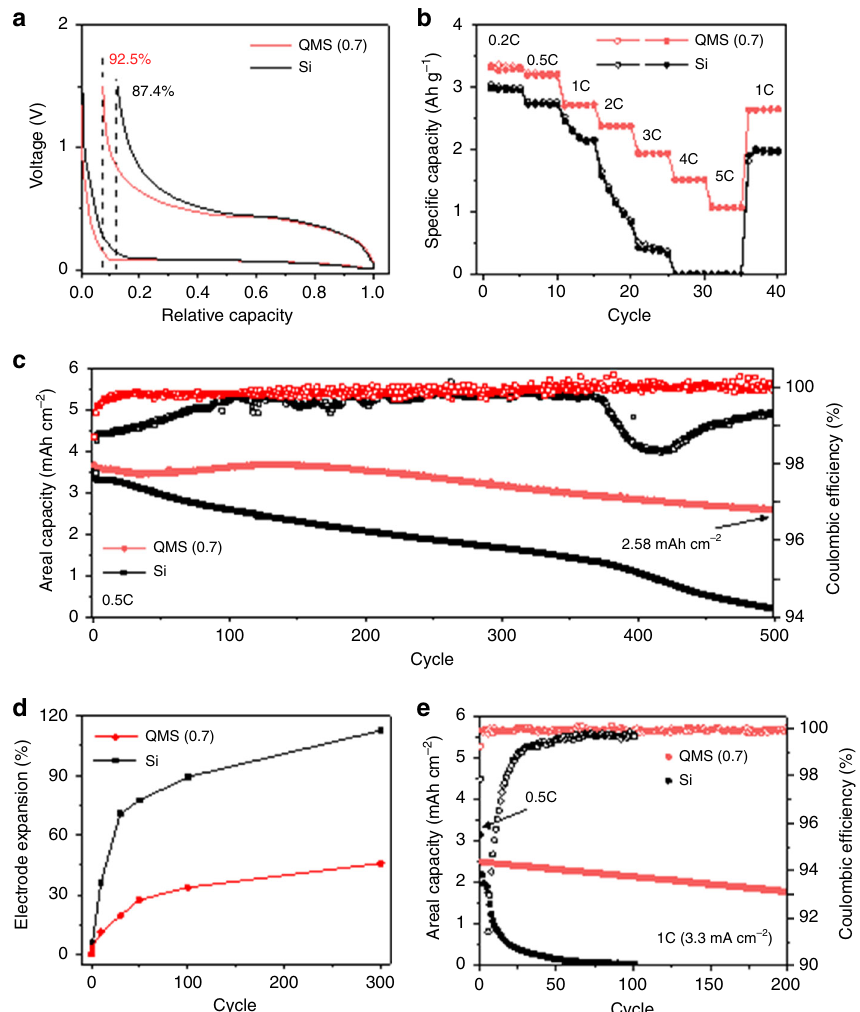
Fig. 5 Li-ion storage properties of quasi-metallic silicon and Si electrodes. a First charge – discharge pro fi les of QMS(0.7) and Si electrodes at a C-rate of 0.05 C. b Charge areal capacity retention of both electrodes at 0.5 C with the corresponding Coulombic ef fi ciency. c Speci fi c capacity plots for both electrodes at different C-rates from 0.2 C to 5 C. d Electrode expansion ratio during 300 cycles for both electrodes. e Full-cell cycle retention at 1 C (3.3 mA cm − 2 ) along with the coulombic ef fi